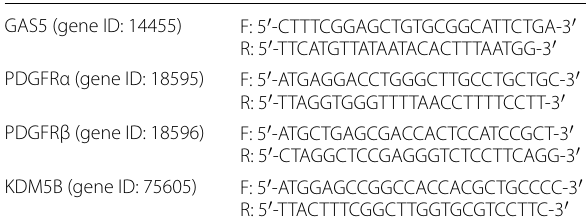
Table 2 The primers used for establishing the overexpression